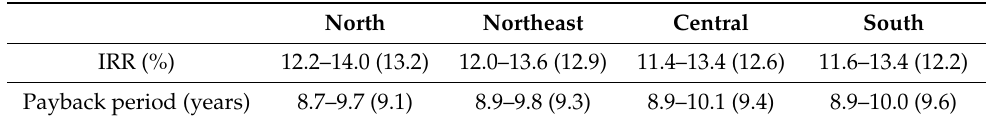
Table A11. IRR and payback period by region for LGS customers under a buyback rate below 3